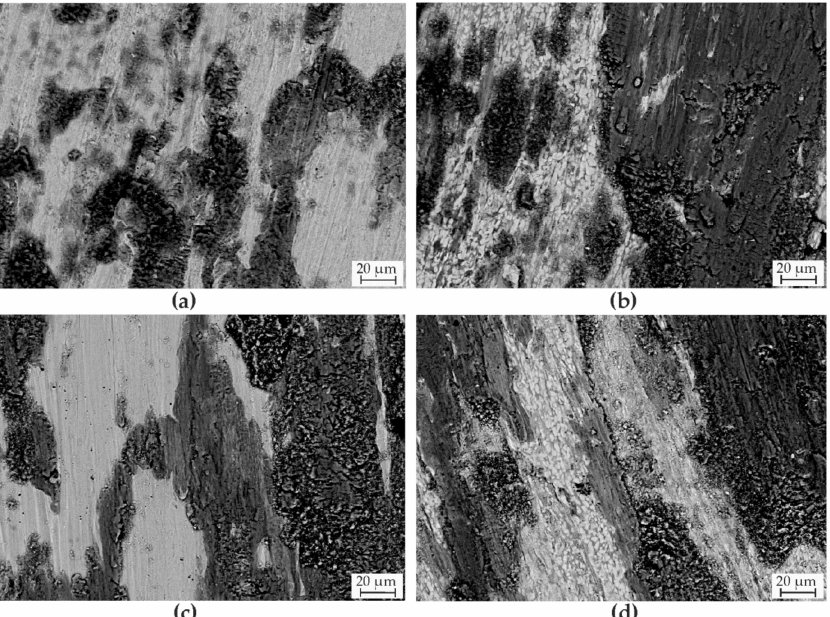
Figure 8. Surfaces (SEM, BSD) of the EHEA Al 0.3 CoCrFeNiNb 0.5 after ball-on-disk testing of ( a ) un- treated and ( b ) heat-treated SPS bulk material as well as ( c ) untreated and ( d ) heat-treated LMD coating. Oxidational wear was identified for all conditions. Grooves were detected in the untreated conditions. Due to heat treatment, the wear tracks showed plastic deformation.